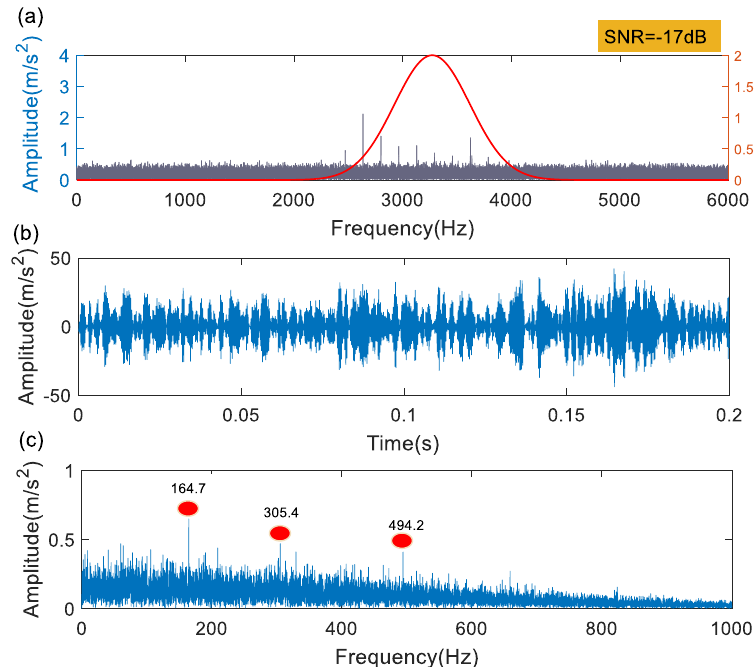
Figure 18. Results of Morlet wavelet on outer ring fault at the SNR of −17 dB: ( a ) the signal spectrum and optimal filter; ( b ) filtered signal; ( c ) the envelope spectrum of the filtered signal.